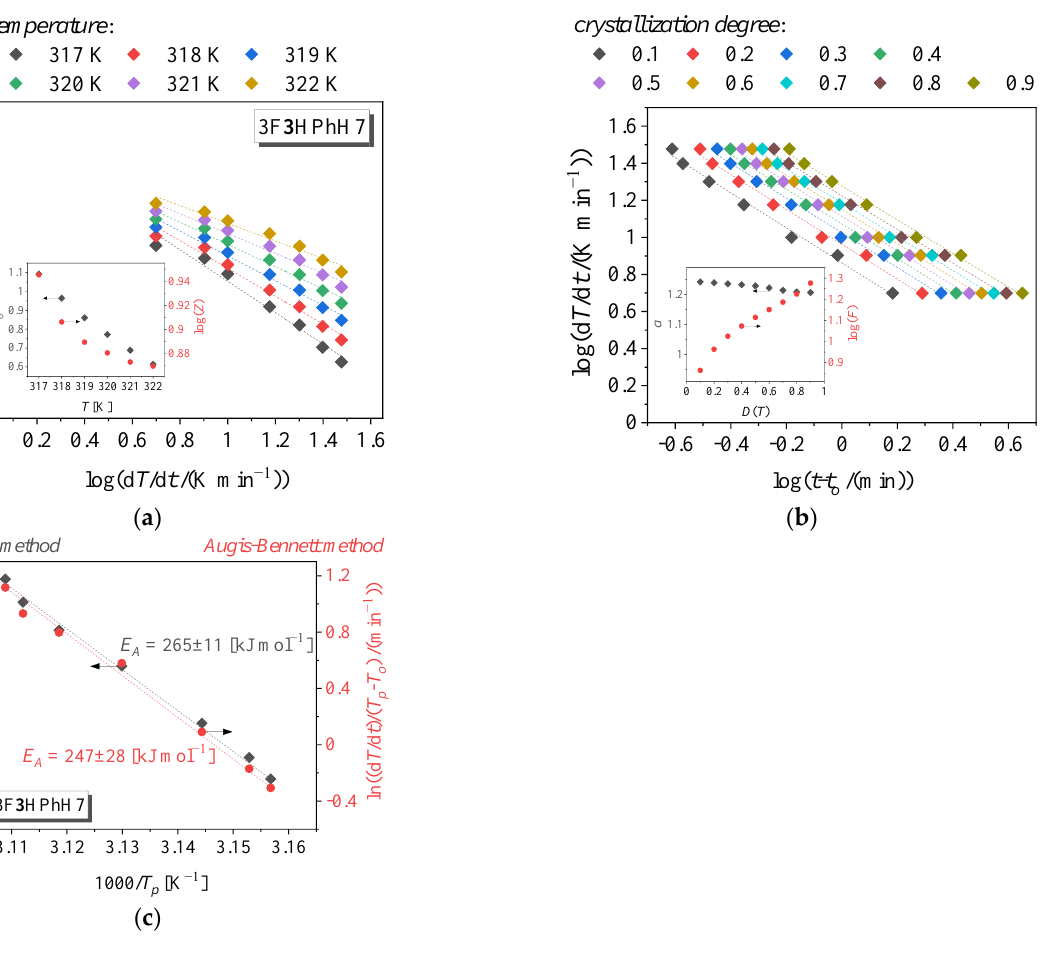
Figure 8. Ozawa plots ( a ), Mo plots ( b ) as well as Kissinger and Augis-Bennett plots ( c ) for the non-isothermal cold crystallization of the 3F 3 HPhH7. The inset in ( a ) presents the parameters n O and log( Z ) vs. T obtained from the linear fit of Equation (3). The inset in ( b ) shows the parameters a and log( F ) vs. D ( T ) obtained from the linear fit of Equation (4).